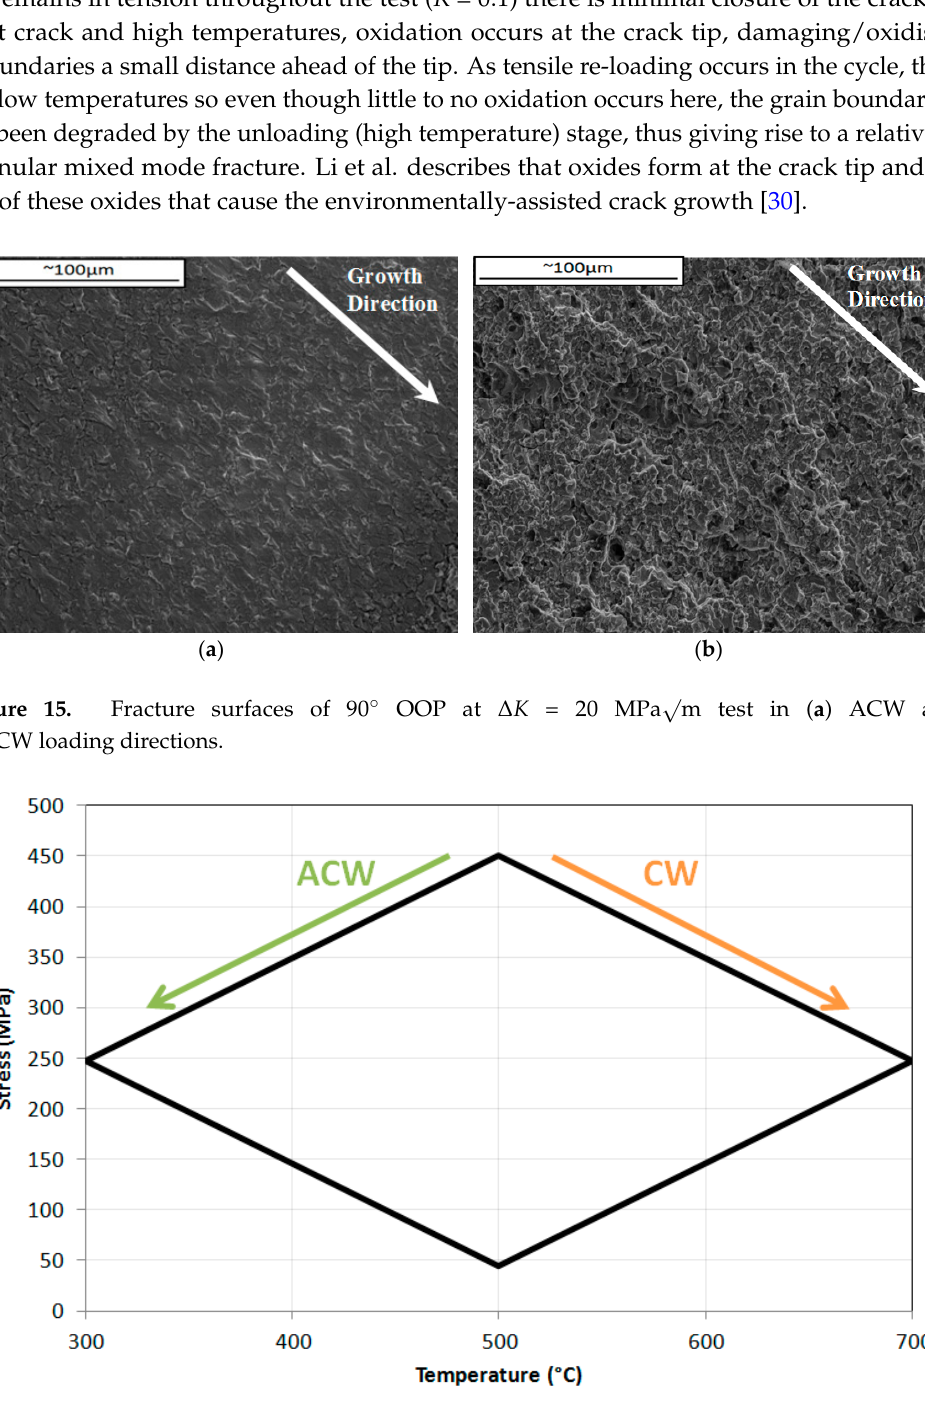
Figure 16. Stress plotted against temperature for 90° OOP cycles in the ACW and CW loading directions.